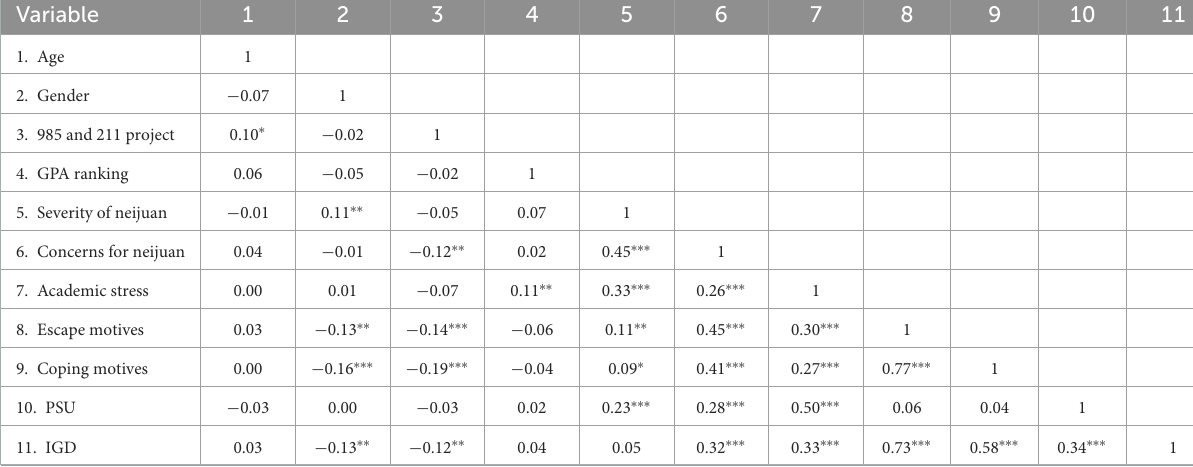
TABLE 3 The correlation matrix of the variables analyzed in this study. Variable